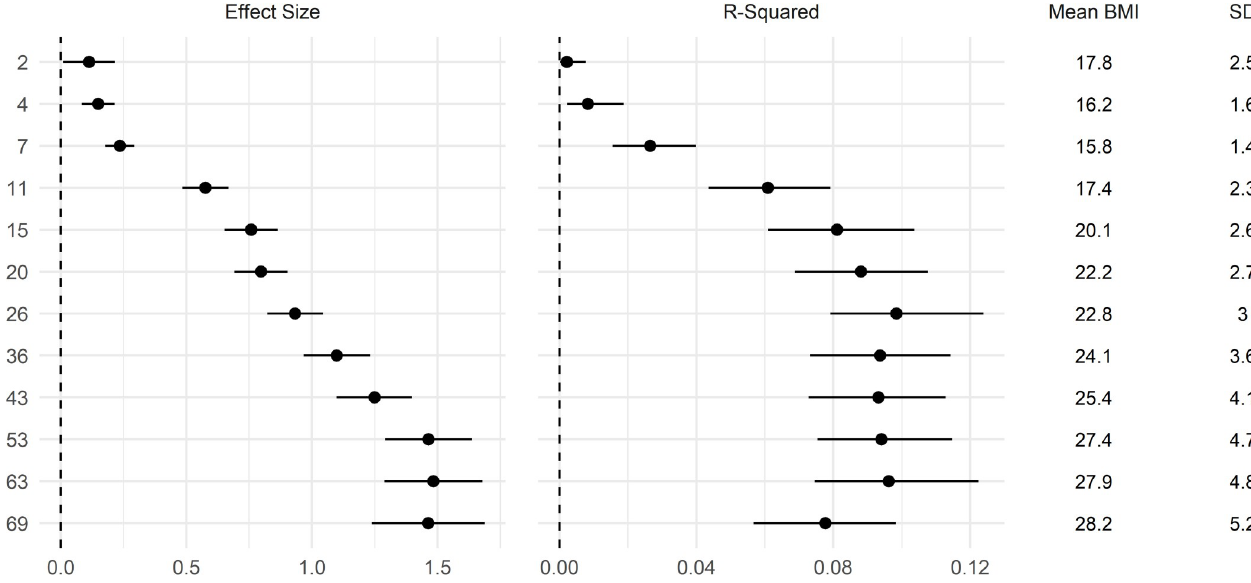
Fig 2. Association between a polygenic index and body mass index (BMI) across life. Drawn from OLS regressions including adjustment for sex and the first 10 genetic principal components, repeated for each polygenic index and age at follow up. Left panel: coefficients: difference in BMI per 1 SD increase in polygenic index (95% CI). Right panel: incremental R 2 compared with OLS regression model of BMI on sex and first 10 genetic principal components (95% CI estimated using bootstrapping [500 replications, percentile method]). Polygenic index from Khera et al [4]; used an initial sample of adults.